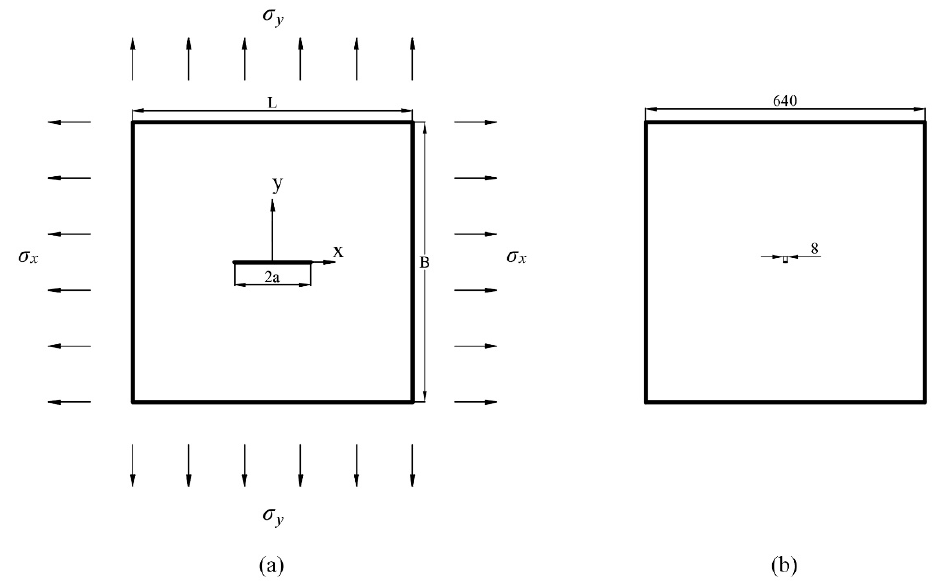
Figure 8. ( a ) Loading condition of the plate with a horizontal crack in the center; ( b ) Size comparison between crack and plate in the example (unit: mm). Table 1. Configuration of the simulation. Parameters